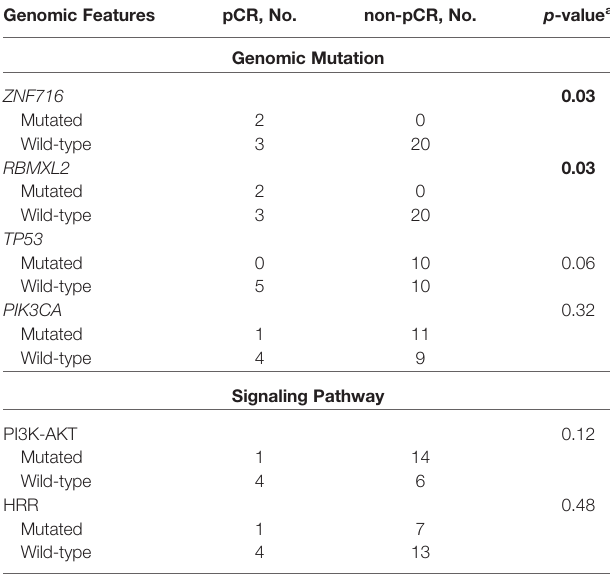
TABLE 2 | Genomic Features in Relation to Pathologic Complete Response (pCR).